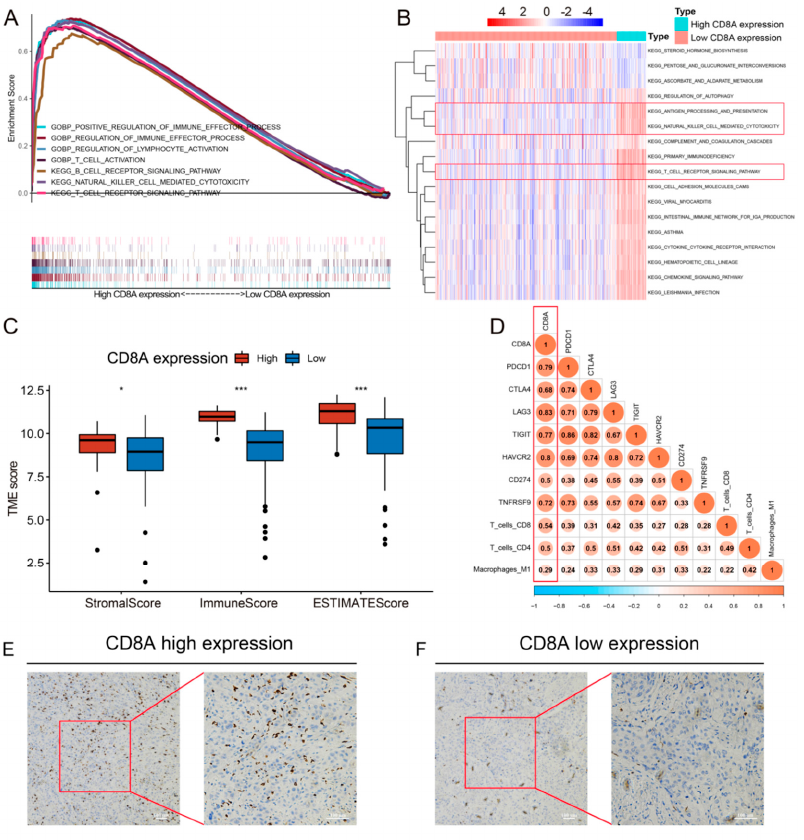
Figure 5. Biological analysis of CD8A. ( A ) Gene set enrichment analysis for comparing biological pathways between high and low CD8A expression groups. ( B ) Gene set variation analysis analyzed the different biological pathways between high and low CD8A expression groups. ( C ) The different levels of TME scores between low and high CD8A expression groups. ( D ) The association of CD8A with TIICs and critical immune checkpoint genes. ( E ) Patient 1: an 88-year-old man with MIBC and IHC-based CD8A high expression. ( F ) Patient 2: a 65-year-old man with MIBC and IHC-based CD8A low expression. TME, tumor microenvironment; TIICs, tumor-infiltrating immune cells; IHC, im- munohistochemistry; MIBC, muscle-invasive bladder carcinoma. *: p < 0.05, ***: p < 0.001.